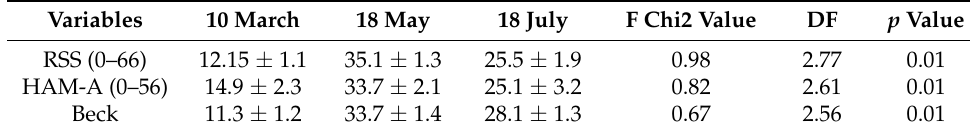
Table 9. Comparison of mean value and SD of the caregivers’ parameters.